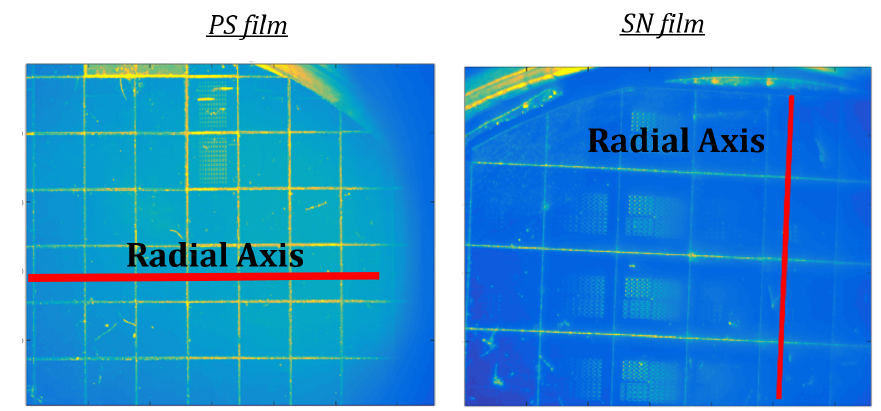
Figure 5. Polysilicon (PS, left) and silicon nitride (SN, right) device surface images and radial axes chosen for the stress distribution profile (SDP) cross-sections evaluated.